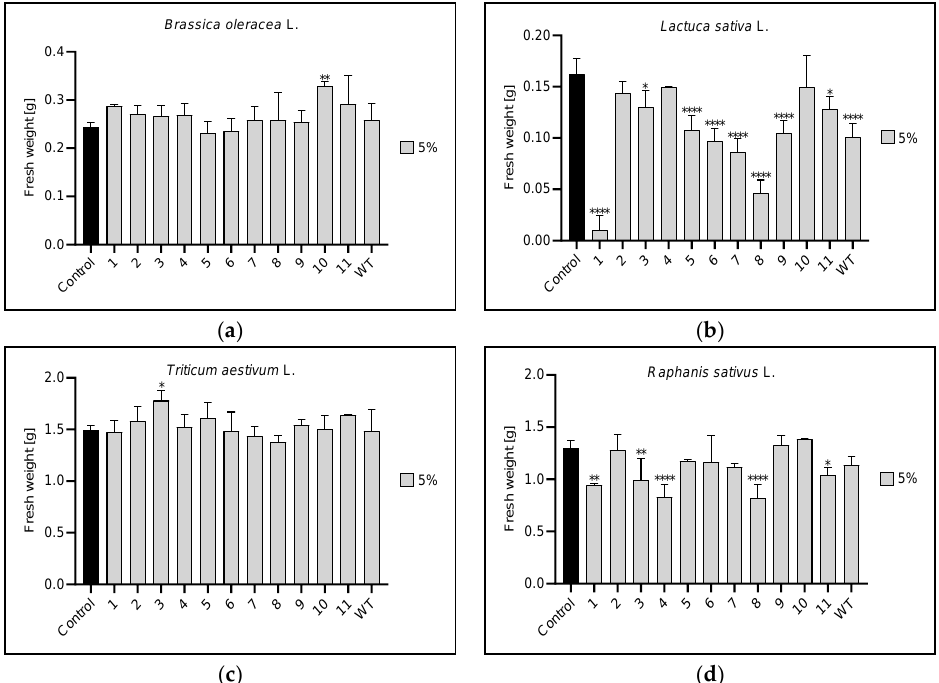
Figure 12 . Fresh weight of broccoli ( a ), lettuce ( b ), wheat ( c ), and radish ( d ) sprouts treated with 5% concentration for all algae clones tested (1-11, WT) and control (Control). Values represent mean ± SD, n = 10 plants, * p < 0.1, ** p < 0.01, **** p < 0.0001 compared to control (ANOVA and Dunnett’s a posteriori test).